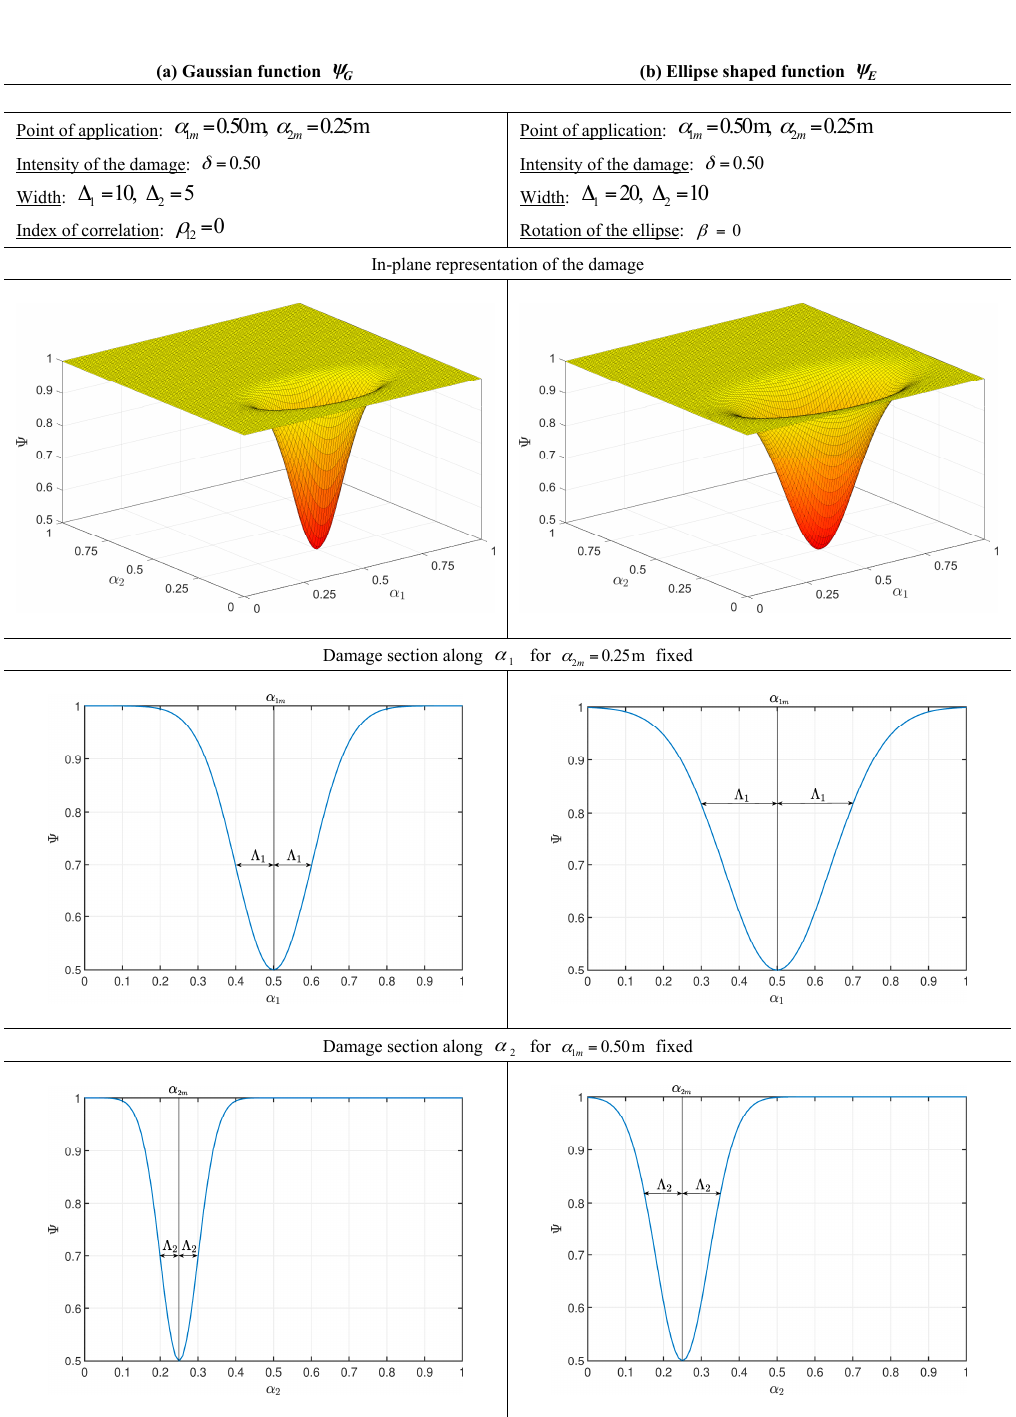
Figure 2. Geometric meaning of the corresponding parameters for the two-dimensional distributions employed to model a generic damage, within a square reference domain with α 1 , α 2 ∈ [ 0,1m ] : ( a ) Gaussian function; ( b ) ellipse shaped